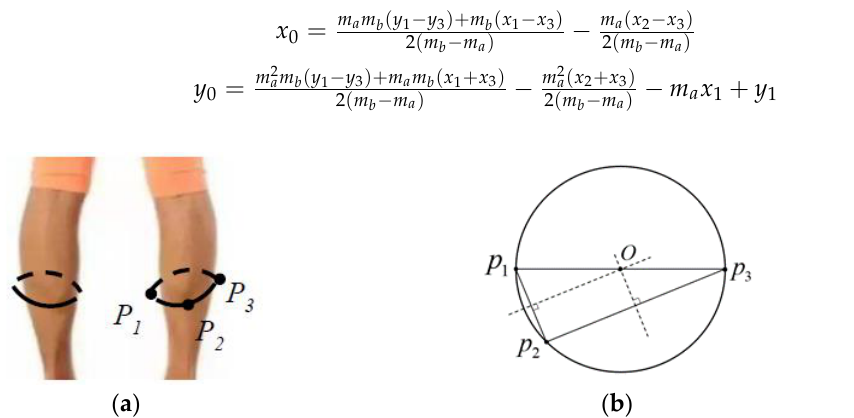
Figure 5. The feature extraction of the legs. ( a ) Circle-like contour recognition of legs. ( b ) Circle-like feature calculation.